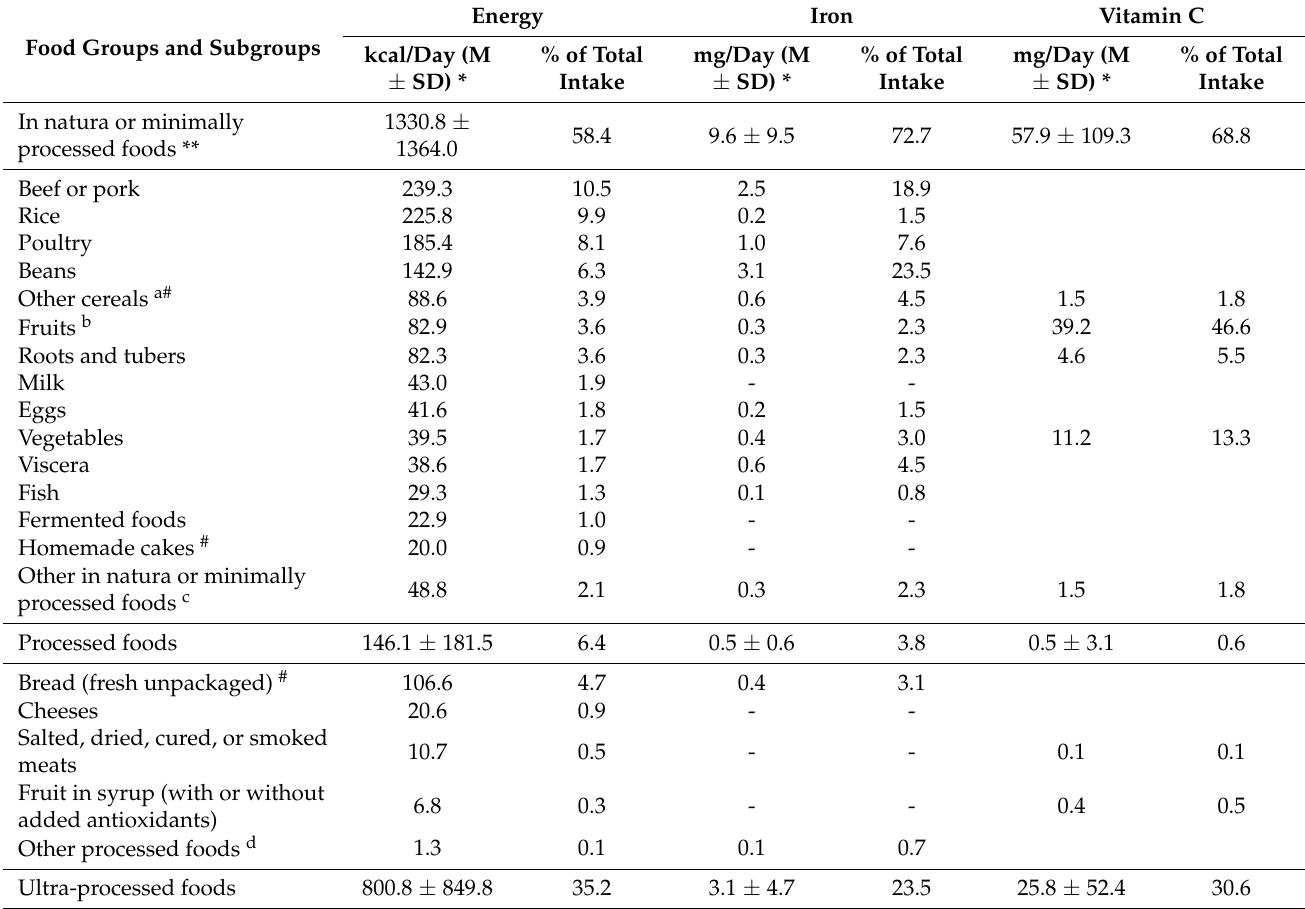
Table 2. Relative and absolute consumption of energy, iron, and vitamin C from foods according to the NOVA